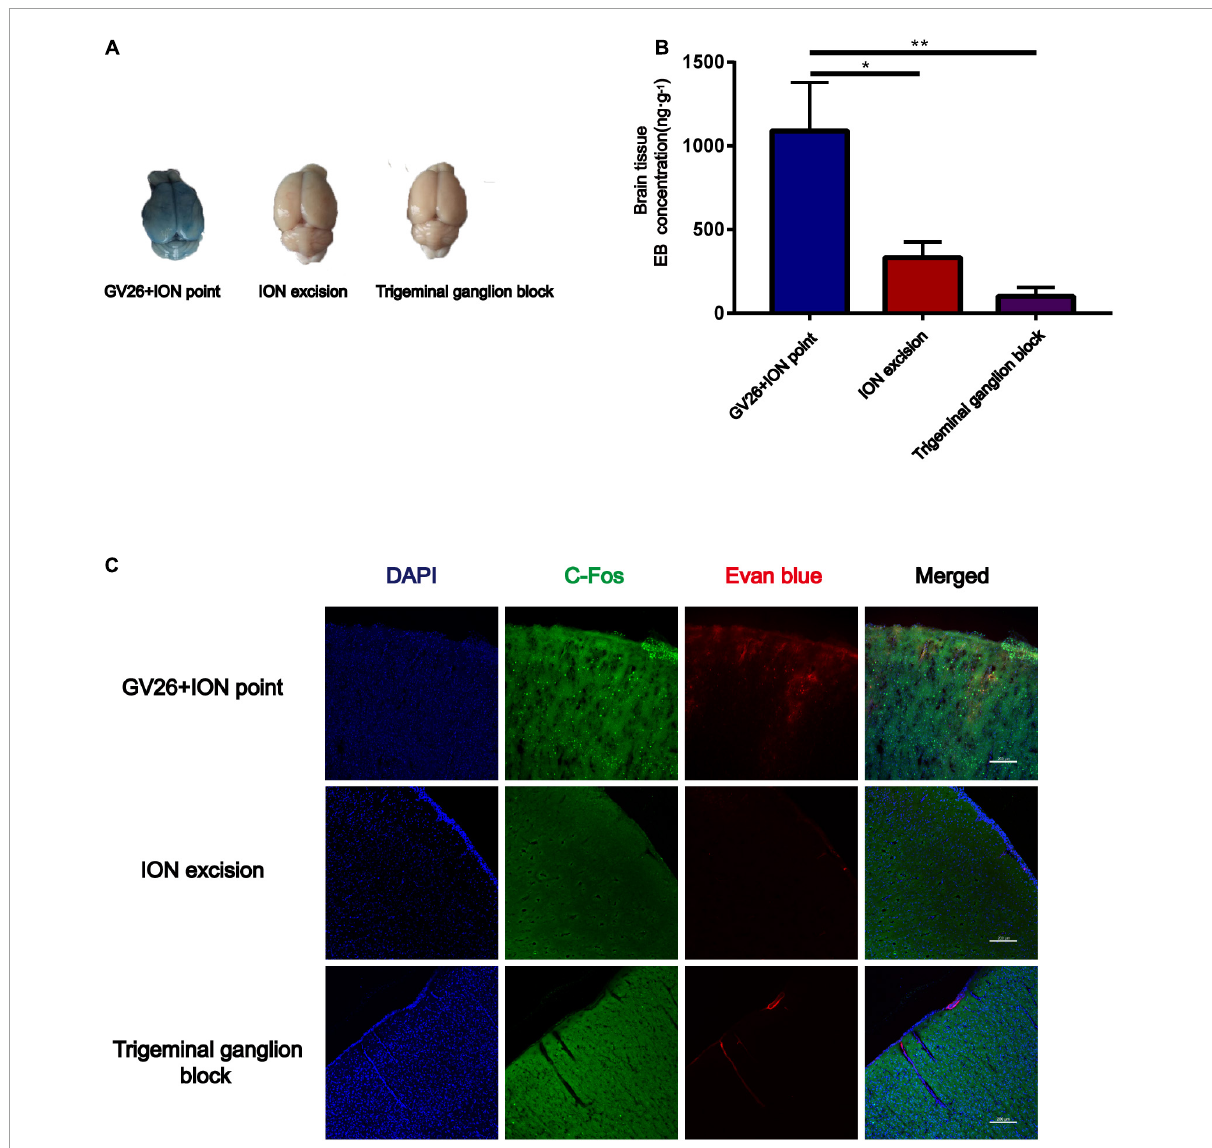
FIGURE3 Verification of the role of trigeminal nerve in promoting BBB opening by infraorbital nerve excision and trigeminal ganglion block. (A) Shows the degree of brain EB penetration of each group under naked eye observation. (B) Shows EB concentration in the cerebral cortex of each group, * P < 0.05, GV26 + ION point group vs. ION excision group; ** P < 0.01, GV26 + ION point group vs. trigeminal ganglion block group, n = 6/group. (C) The cerebral cortex EB and c-Fos fluorescence expression of the different groups. The ION excision group and